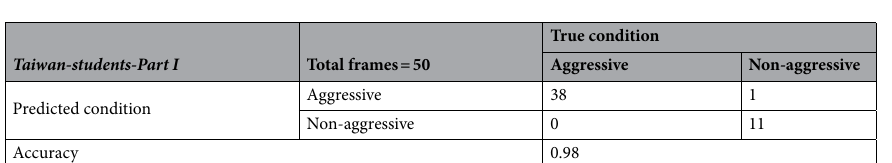
Taiwan-students-Part I